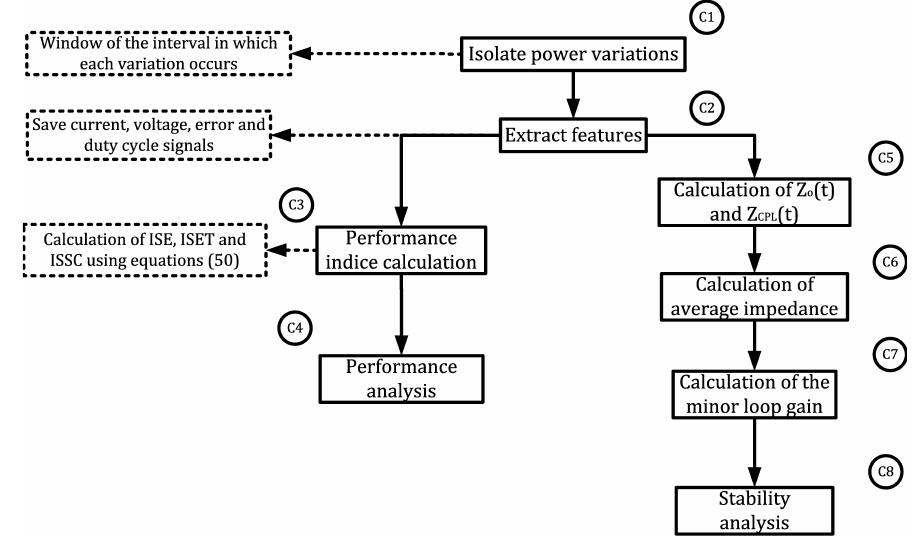
Figure 16. Flowchart on data